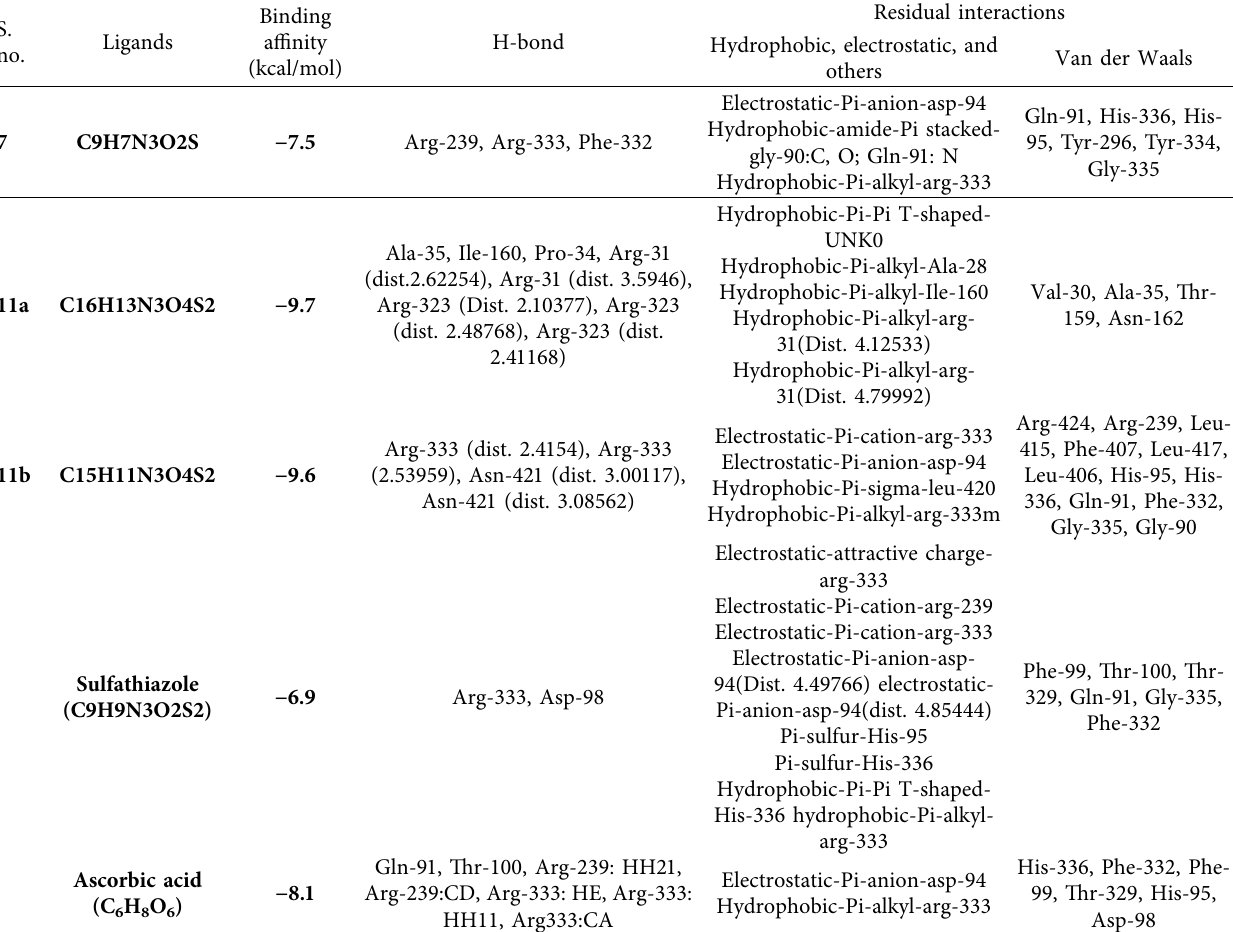
Table 4: Molecular docking results of synthesized compounds against Human myeloperoxidase (PDB ID: 1DNU).